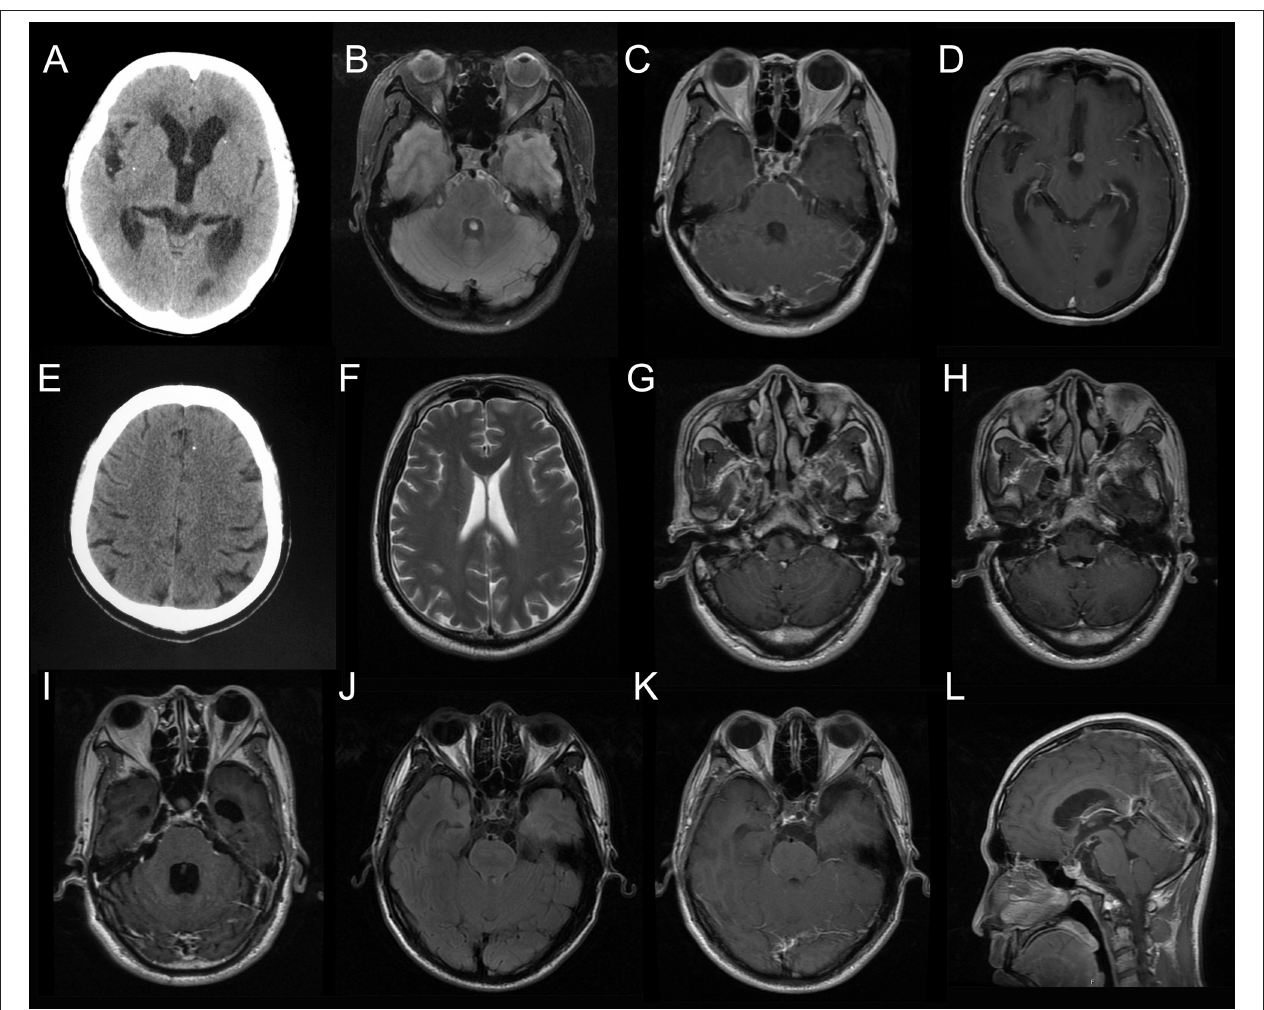
FIGURE 1 | Neuroimaging results of the patients. Head computed tomography (CT) for Case 1 showed scattered parenchymal calcified lesions (A) . Brain magnetic resonance imaging (MRI) for Case 1 showed enhancement of the basal meninges and lesions in prepontine cistern ( B , fluid attenuated inversion recovery, FLAIR; C , T1-weighted image with contrast, T1W + C) and interpeduncular cistern ( D , T1W + C). Head CT for Case 2 showed a single calcified lesion in the left frontal lobe (E) . Brain MRI for Case 2 was essentially normal (F) . Brain MRI for Case 3 showed enhanced lesion posterior to the medulla ( G, H , T1W + C) and hydrocephalus ( I , T1W + C). Brain MRI for Case 4 showed multiple cystic lesions in the suprasellar cistern ( J , FLAIR; K,L , T1W +